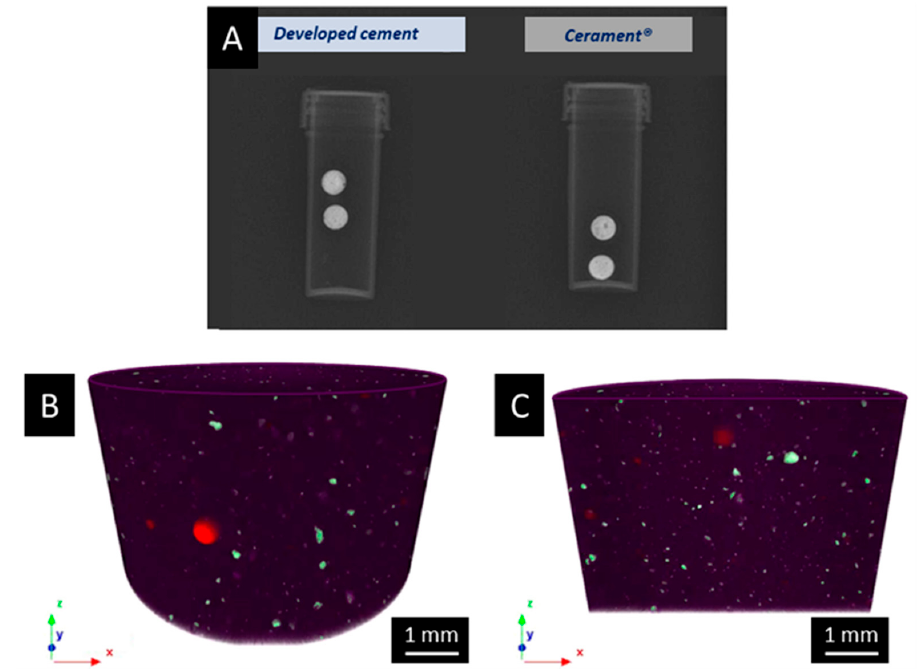
Figure 3. Radiopacity assessment: ( A ) Fluoroscopy imaging acquired on the developed cement (left) and commercial reference, Cerament ® (right); ( B , C ) ZrO 2 distribution evaluation through Micro-CT analysis (purple: CSD matrix, red: air, green: ZrO 2 particles), front view ( B ) and cross-section ( C ).